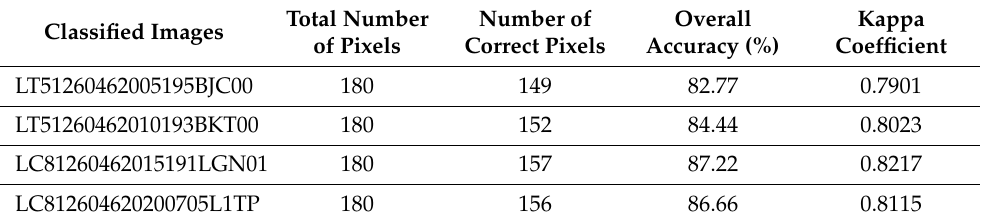
Table 3. Accuracy assessment of satellite image classification.